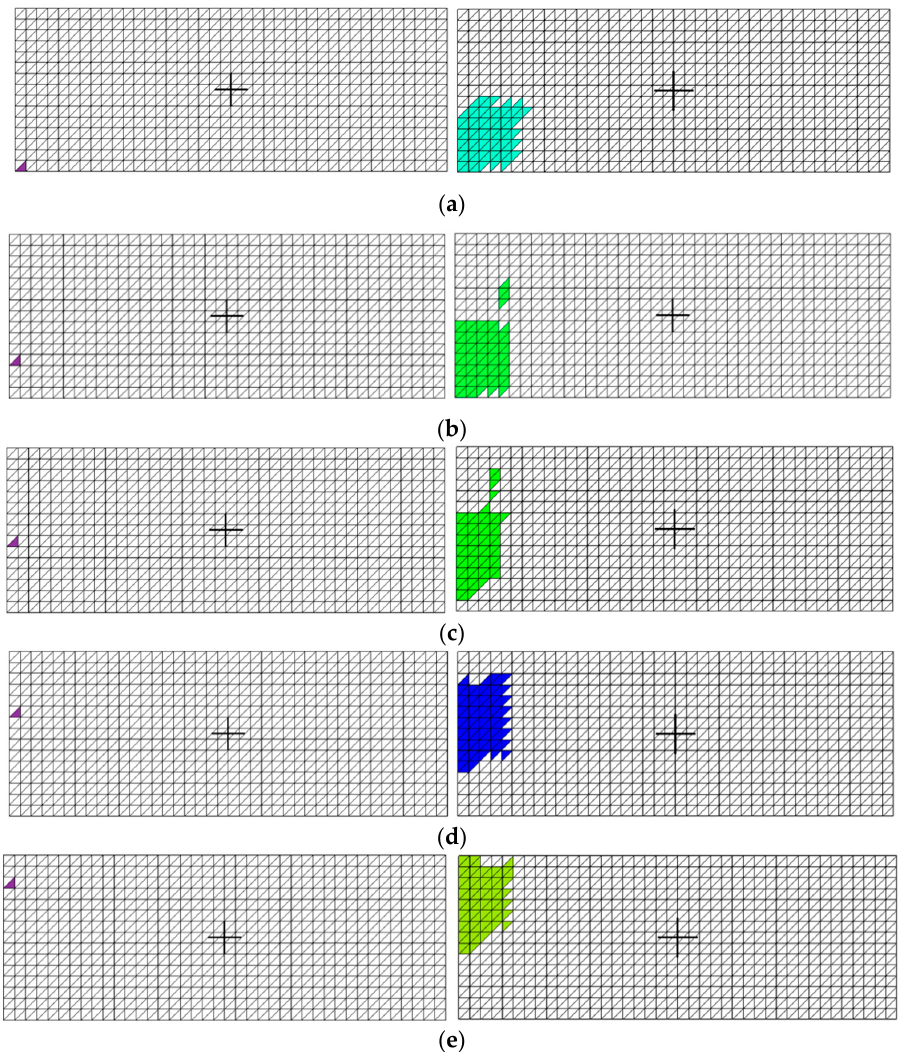
Figure 9. Initial starting elements (left) and resulting optimised preform geometries (right) of the performed optimisations. ( a ) Starting element 1, ( b ) Starting element 2, ( c ) Starting element 3, ( d ) Starting element 4, and ( e ) Starting element 5.